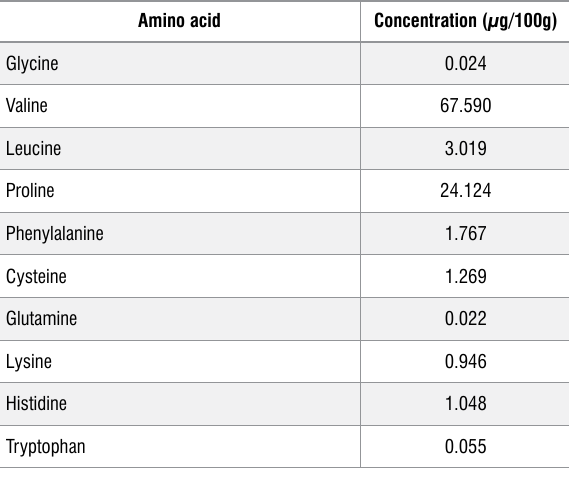
Amino acid content of yellow variety of tiger nut